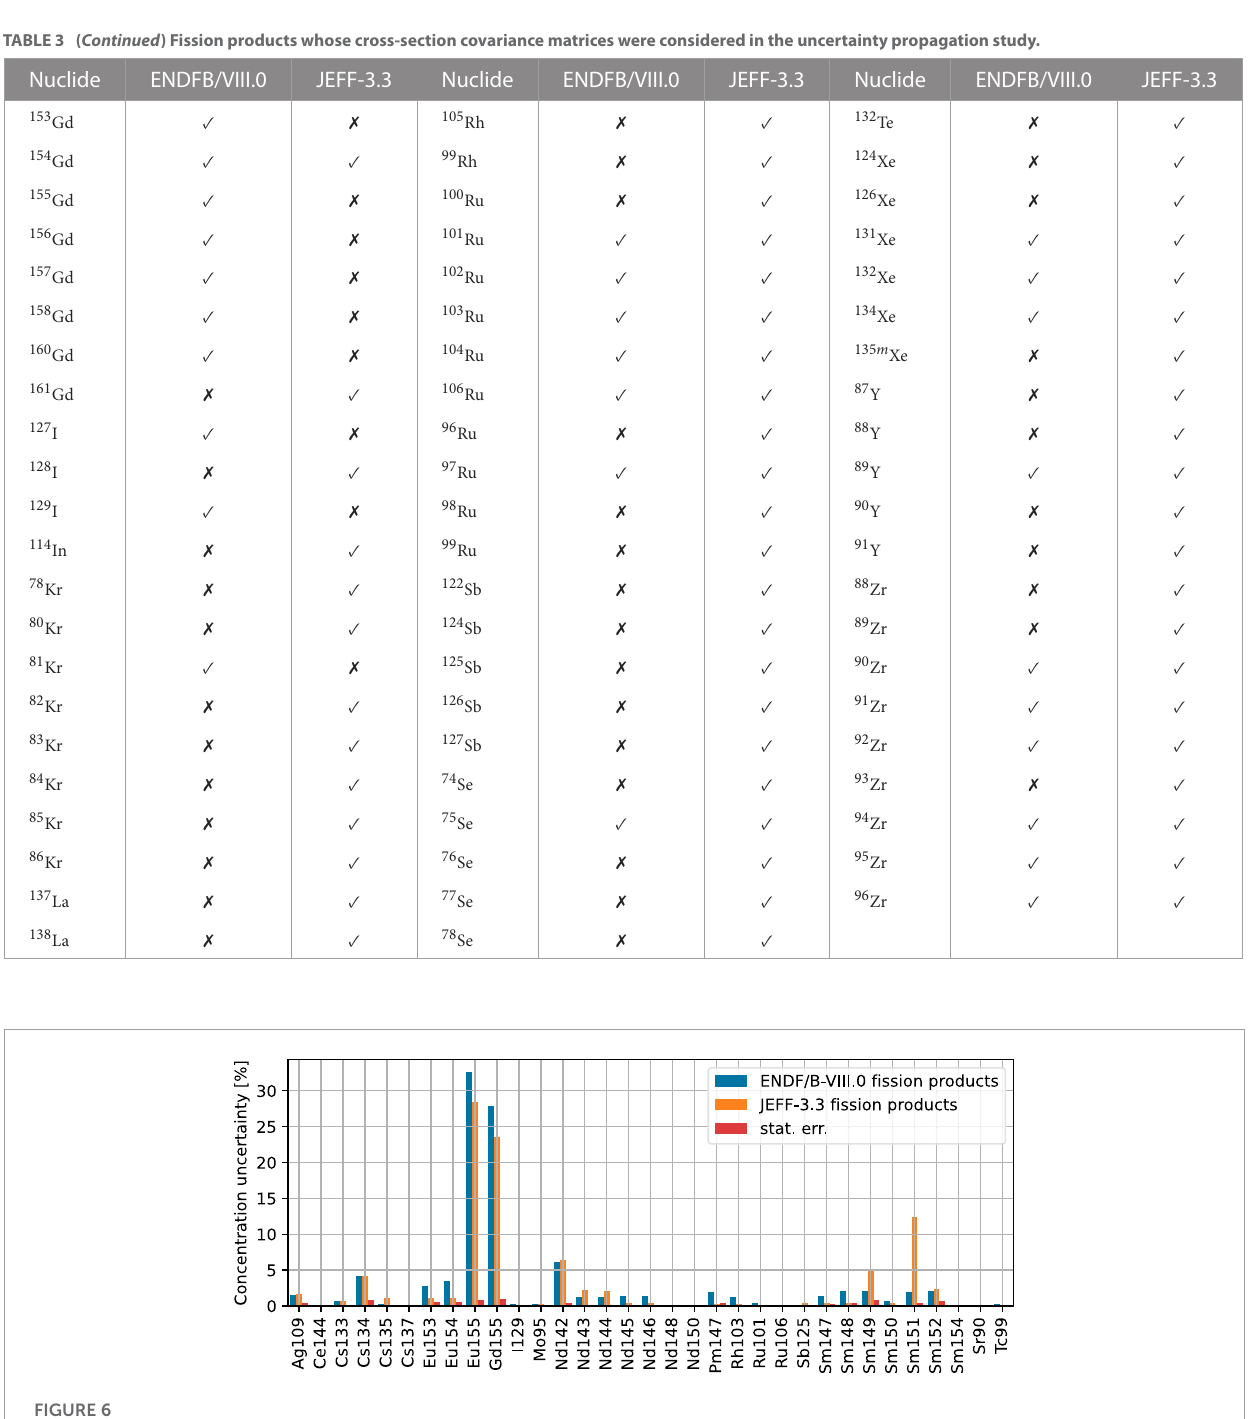
FIGURE 6 Nuclear data uncertainty on fission product composition and comparison with the propagated statistical error inherent to the Monte Carlo